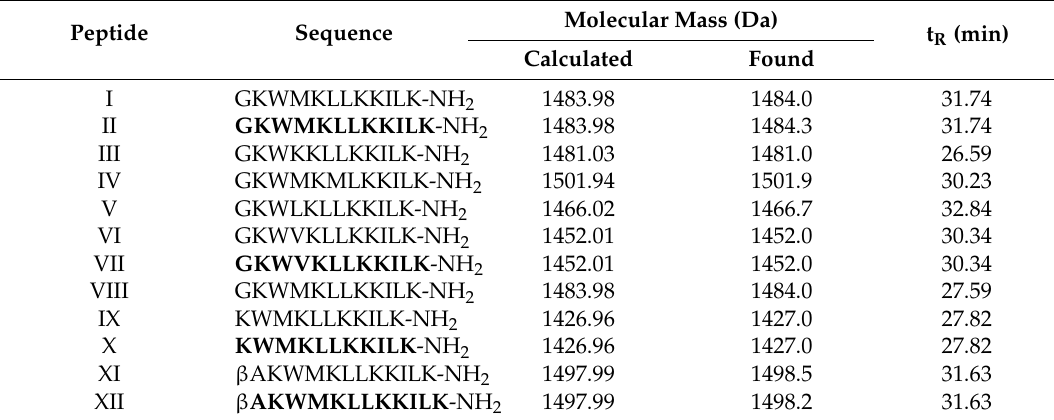
β A, beta-alanine; D -amino acids are shown in bold letters.